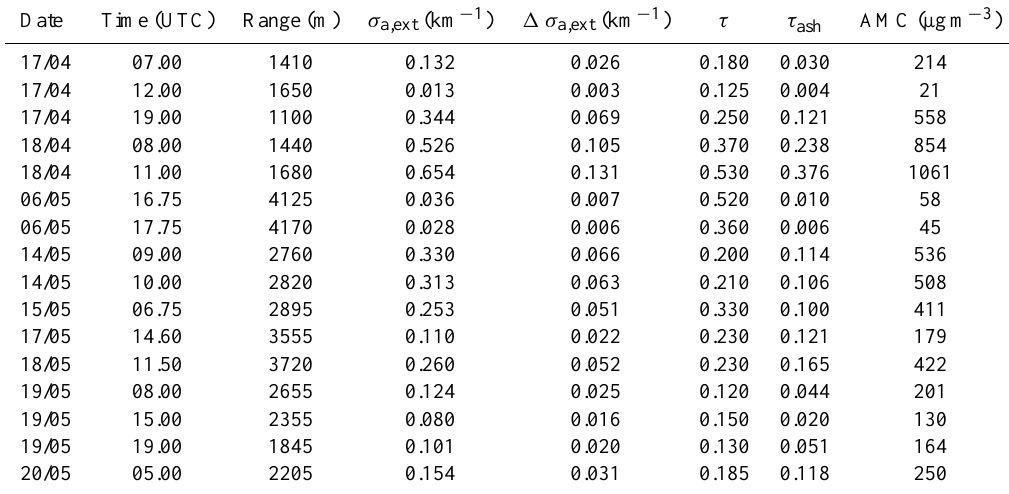
Table 1. Summary of the main characteristics of volcanic ash layers detected over Lille. The range of the layer, extinction σ a, ext , its uncer- tainty 1σ a, ext , and AMC estimation are given for the relative maximum concentration detected in the profile. τ and τ ash are, respectively, aerosol optical depth for the total atmospheric column and ash